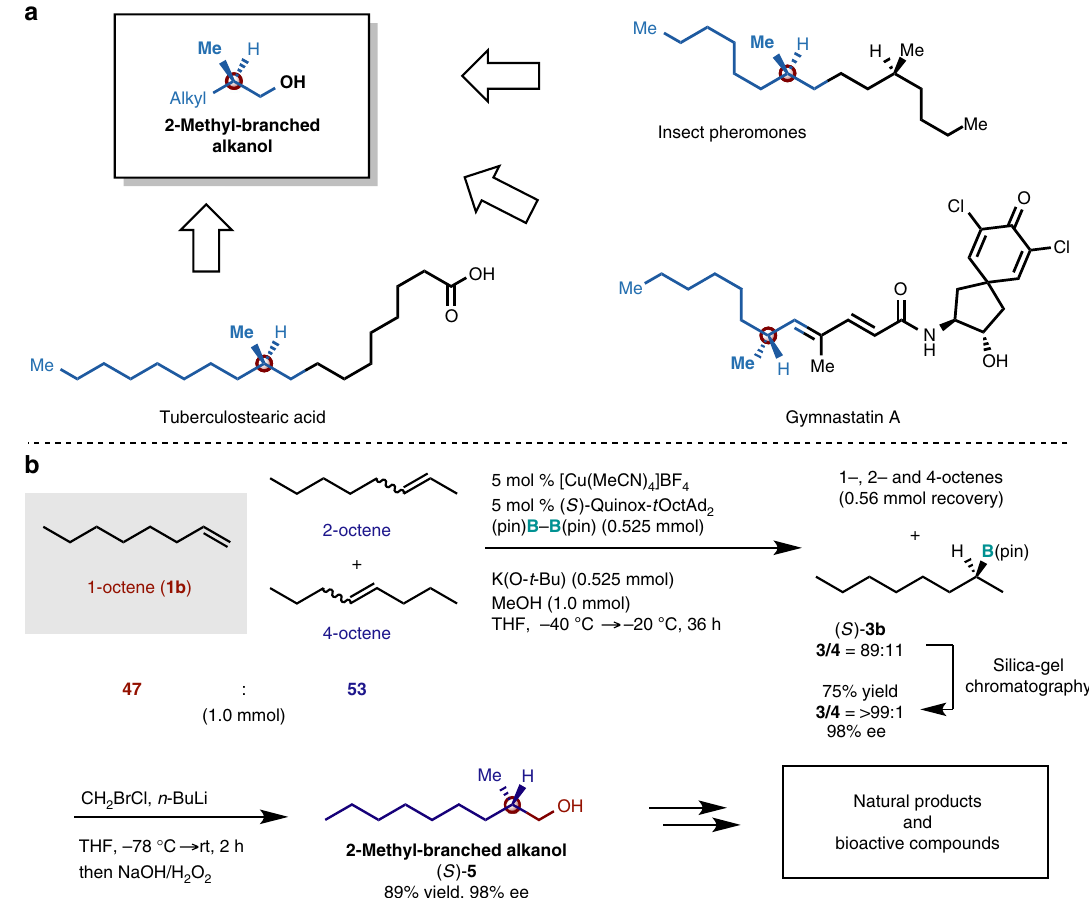
Fig. 7 Synthetic applications of the Markovnikov hydroboration products. a Chiral 2-methyl alkanols as versatile intermediates for natural products or bioactive compounds bearing chiral methyl-branched moieties. b Synthesis of 2-methyl-alkanol ( S )- 5 via the enantioselective Markovnikov hydroboration of a mixture of